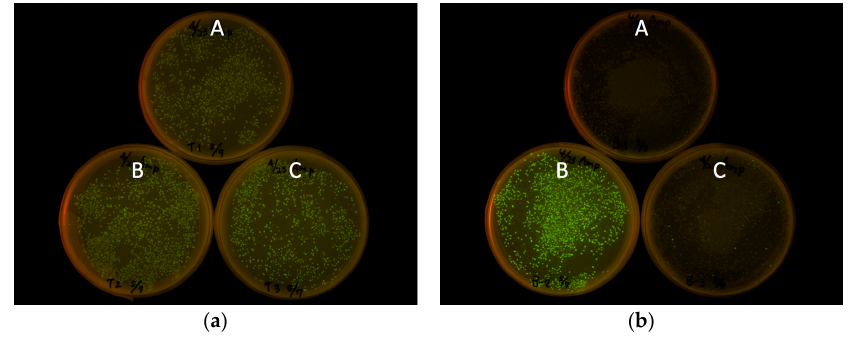
Figure 3. Frame-insensitive expression of eGFP with pRSET-TriEX vector. ( a ) The genes encoding eGFP with different reading frames were inserted in pRSET-TriEX. ( b ) pRSET B was used as a negative control. The labels A, B, and C indicate the frames of eGFP CDS.